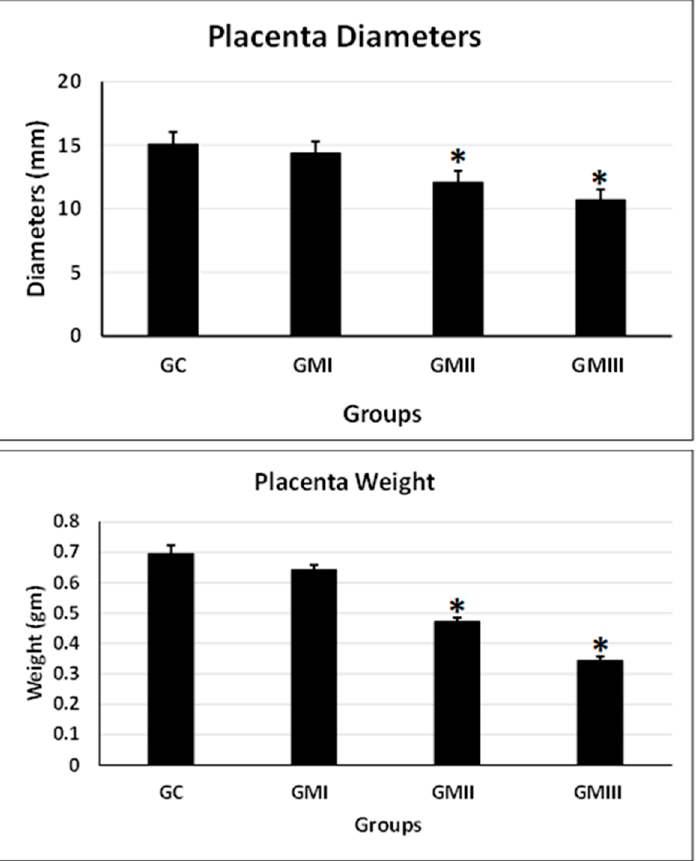
Figure 3. Evaluation of placental parameters (weights and diameters) in the treated pregnant rats with metronidazole. Values are expressed as mean ± standard deviation (M ± SD) n = 10/group. * The values are signi fi cantly di ff erent at p ≤ 0.05 (ANOVA) with Duncan’s multiple range test.